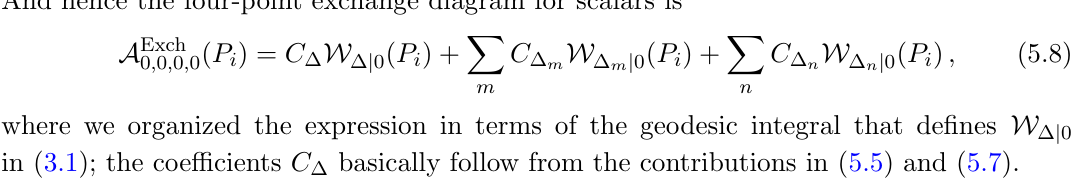
in (5.1), the second diagram to 0 ; 0 ; 0 ; 0 in 1 ; 1 ; 0 ; 0